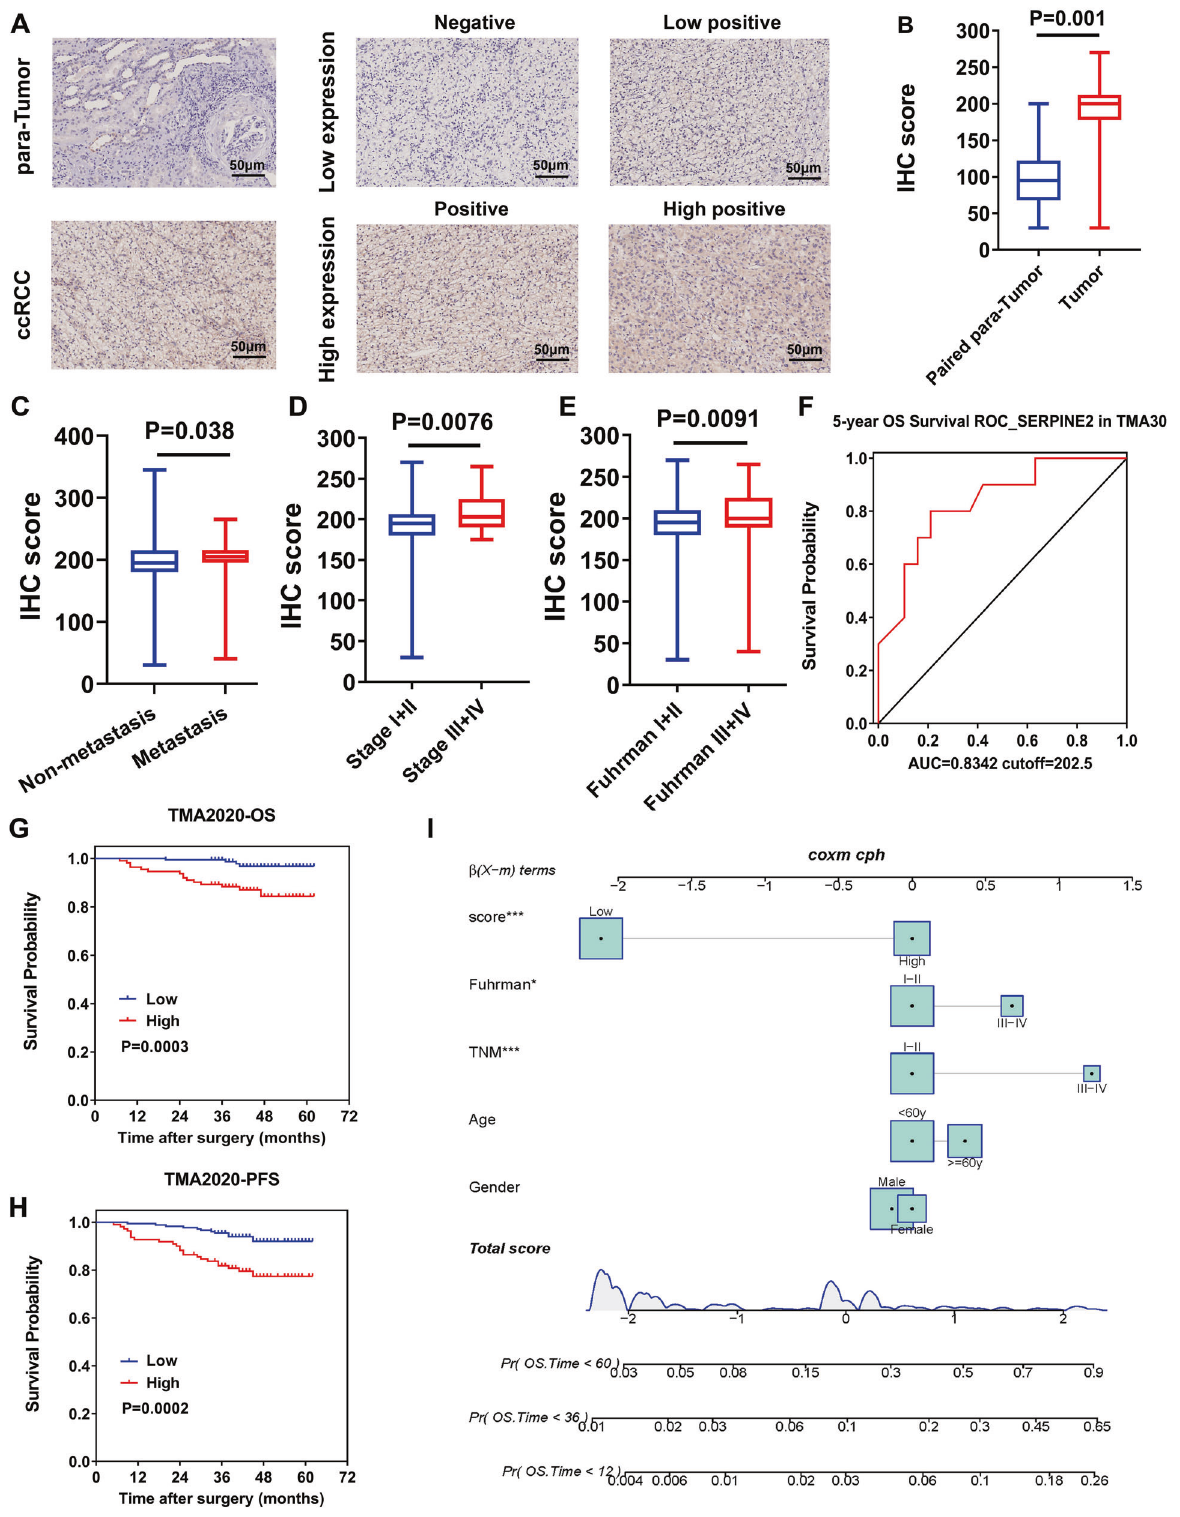
Fig. 6 SERPINE2 predicts poor survival and RCC metastasis in our clinical cohort. A Representative IHC staining and H-score for SERPINE2 in RCC tissues and matched para-tumor tissues (scale bar = 50 μ m). B IHC score between tumor tissues and matched para-tumor tissues. C IHC score between tumor tissues from patients with metastasis and no metastasis. D IHC score between patients with stage I, II and stage III, IV. E IHC score between patients with Fuhrman I, II and Fuhrman III, IV. F The ROC curve for SERPINE2 expression in 5-year OS (TMA30 cohort). G The KM curve for OS difference between SERPINE2 high and low groups. H The KM curve for PFS difference between SERPINE2 high and low groups. I The nomogram for 1-, 3- and 5-year OS. OS overall survival, PFS progression-free survival.